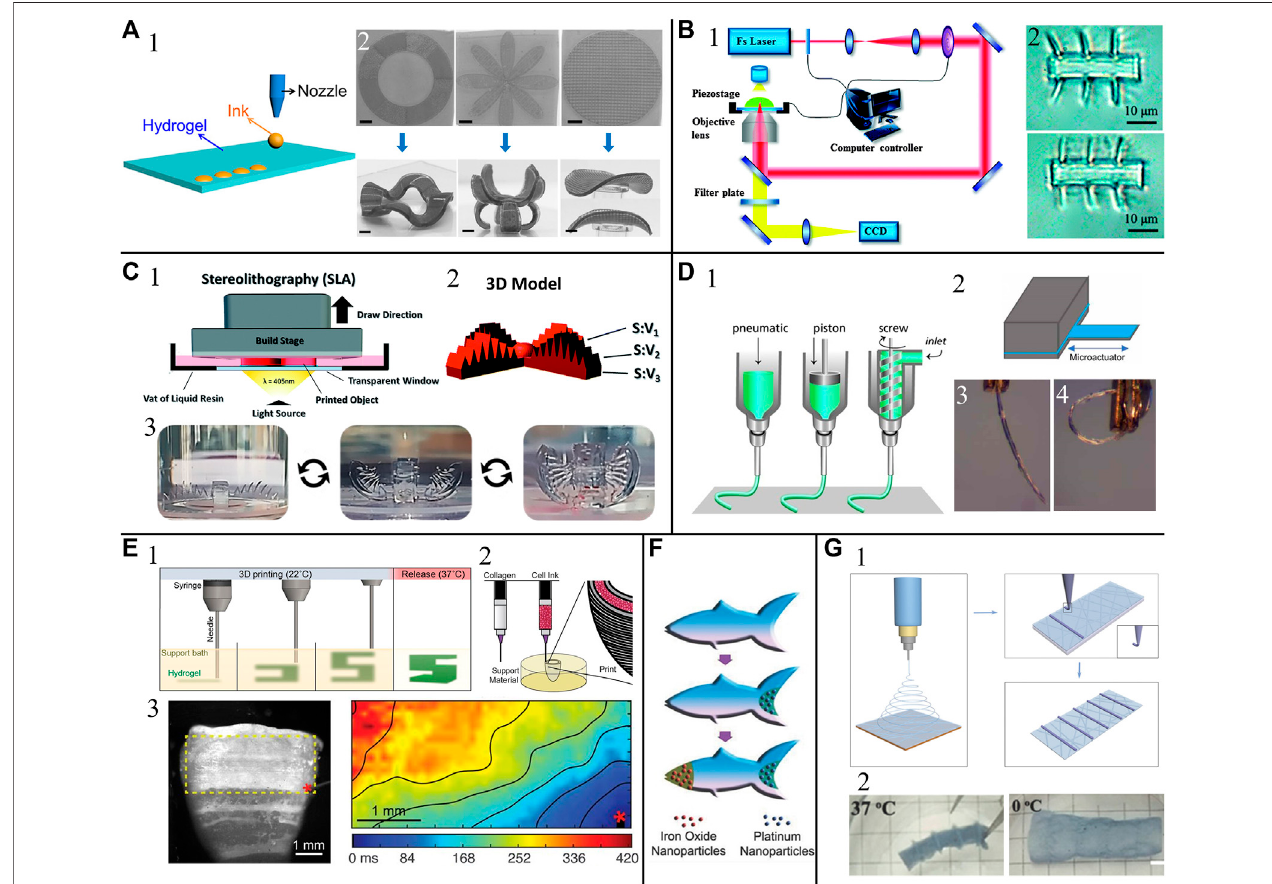
FIGURE 1 | Examples of hydrogel actuators fabricated with (A) inkjet printing, (B) two-photon polymerization printing (2PP), (C) stereolithography (SLA), (D) extrusion-based printing, (E) embedded printing, and (F,G) mixed-mode 3D printing. (A1) The inkjet printing process. (A2) Hydrogel actuators with inkjet printed patterns to achieve controlled 3D deformation. Adapted from (Peng and Wang 2018) ©2018 John Wiley and Sons, Inc. (B1) A typical 2PP process induced by a near- infrared femtosecond laser. Reprinted from (Xing et al., 2015) ©2015 the Royal Society of Chemistry. (B2) 2PP printed hydrogel actuator in water (top) and in 1 M NaCl solution (bottom) . Reprinted from (Xiong et al., 2011) ©2011 the Royal Society of Chemistry (C1) The SLA process (C2) 3D model of an SLA printed hydrogel actuator with varying surface area to volume ratio. (C3) Osmotically driven actuation of the actuator. Adapted from (Odent et al., 2019) ©2019 the Royal Society